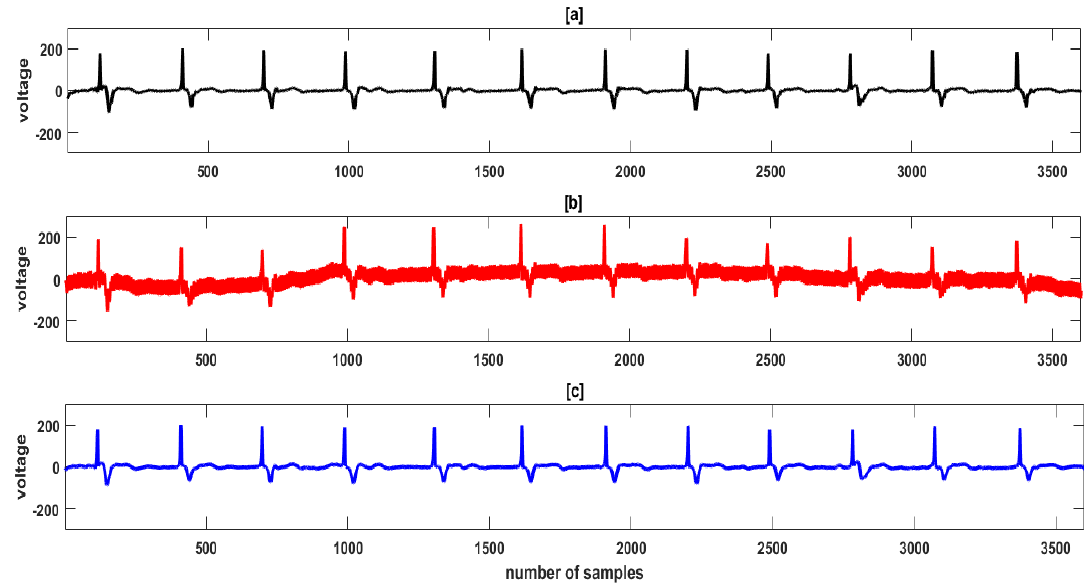
Figure 7. ( a ) Original clean input ECG record no. 102 ( b ) Noisy signal with 50 Hz PLI noise and baseline wander at SNR 0 dB ( c ) Denoised output signal using IF-LWT method.